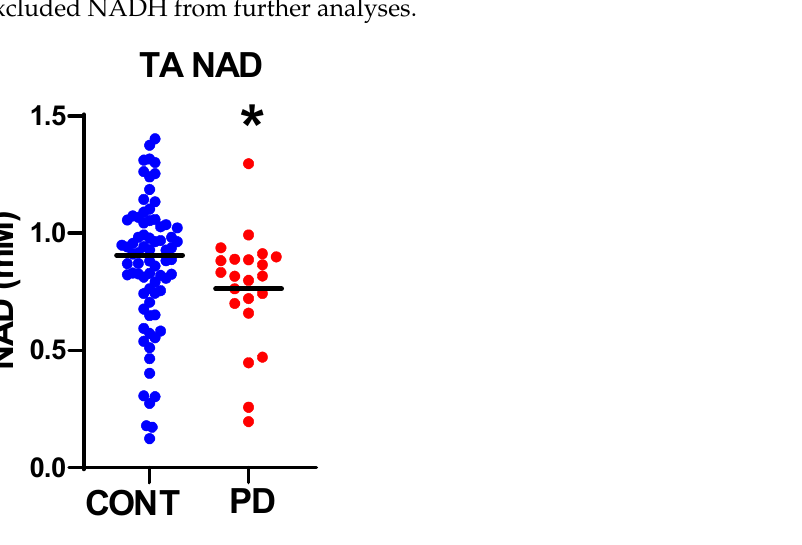
Figure 3. In vivo NAD in skeletal muscles. In vivo NAD concentration measured from 31 P MRS spectra. Solid line indicates mean of each group. * p <